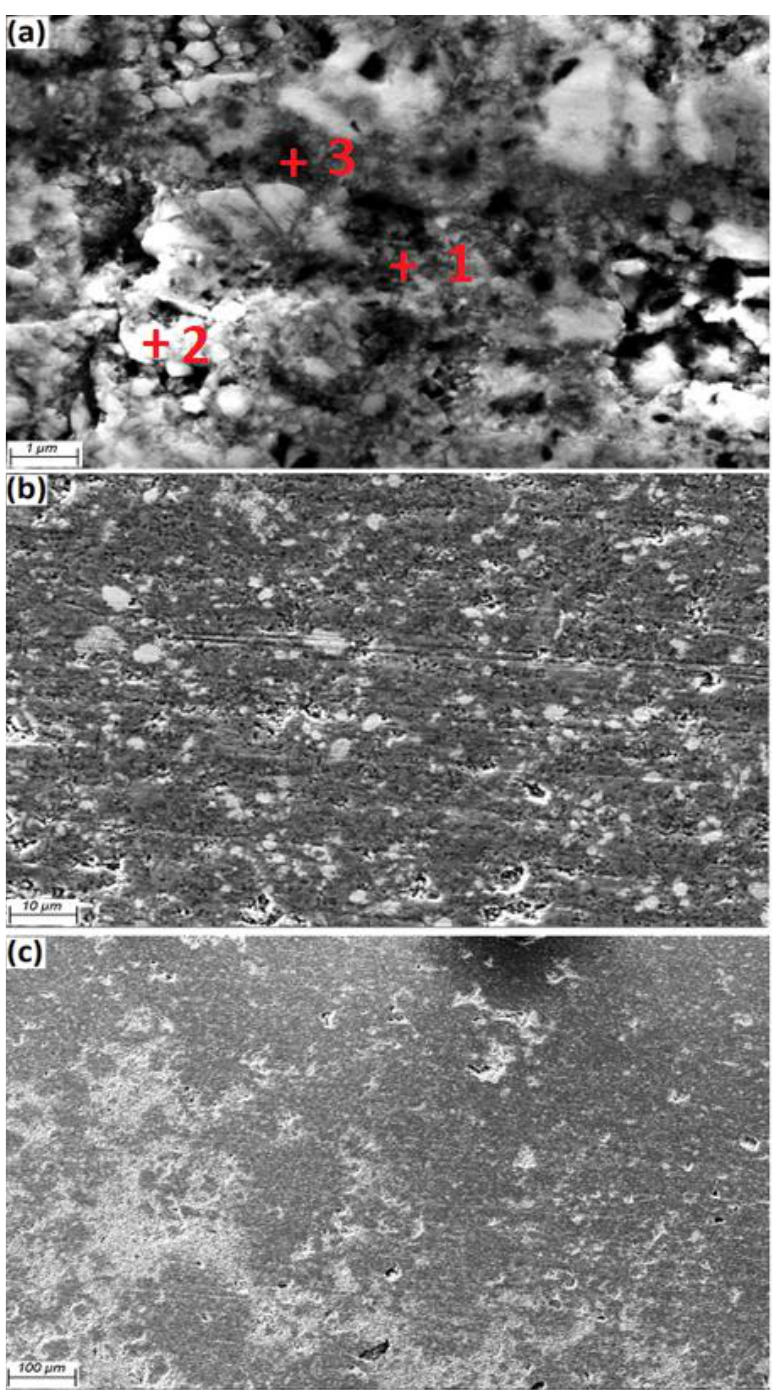
Figure 5. FESEM of a.5 composite sample after etching and heat treatment at 600 °C, ( a ) 1 µm, ( b ) 10 µm, ( c ) 100 µm.